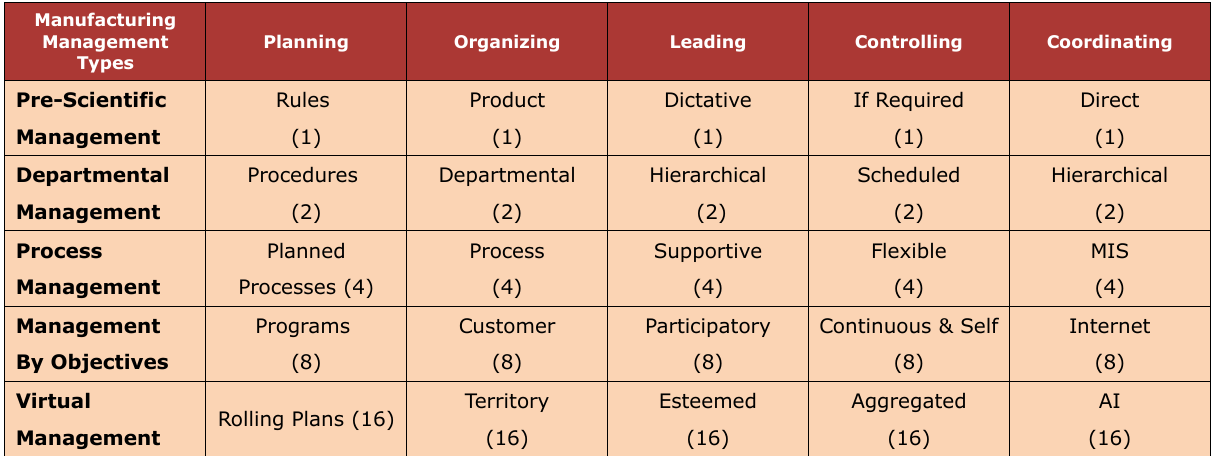
Table 1. Specific Management Functions with respective weights for each Manufacturing Management